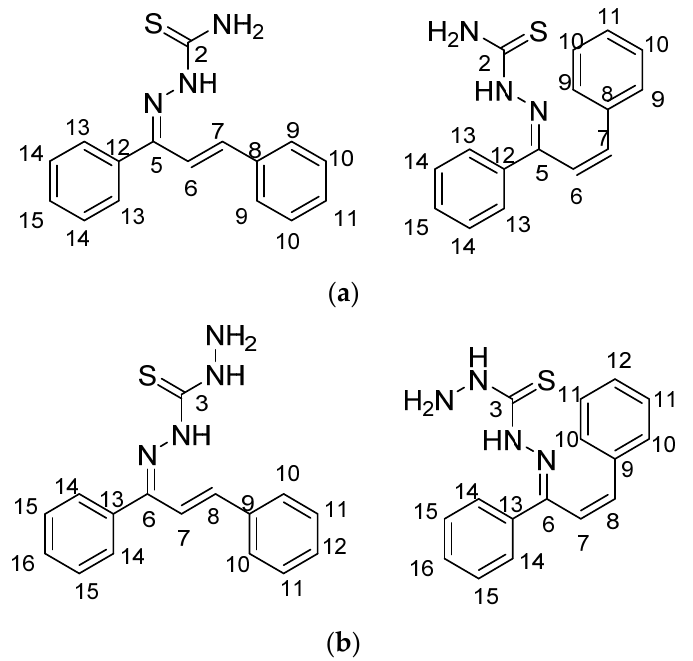
Figure 2. Structure of ( a ) KKI15 in E ( top , left ) and Z isomer ( top , right ) and ( b ) KKI18 in E ( bottom left ) and Z ( bottom right ) isomer with carbons numbered as these are used in the assignment of NMR spectra.